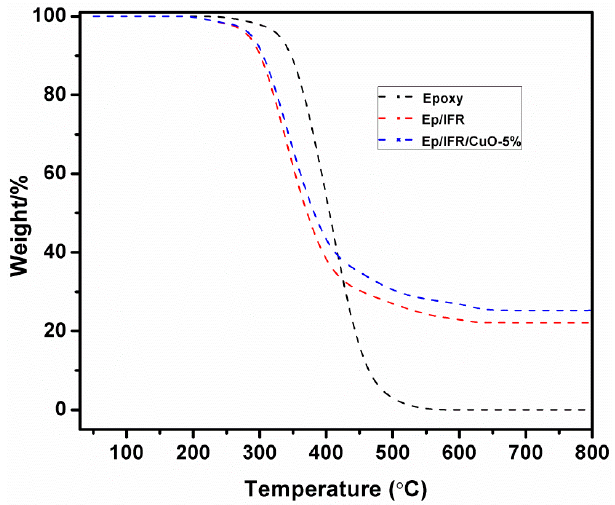
/ IFR, and Ep / IFR / CuO-5% Figure 3. TGA curves of epoxy, Ep/IFR, and Ep/IFR/CuO-5% samples. Figure 3. TGA curves of epoxy, Ep